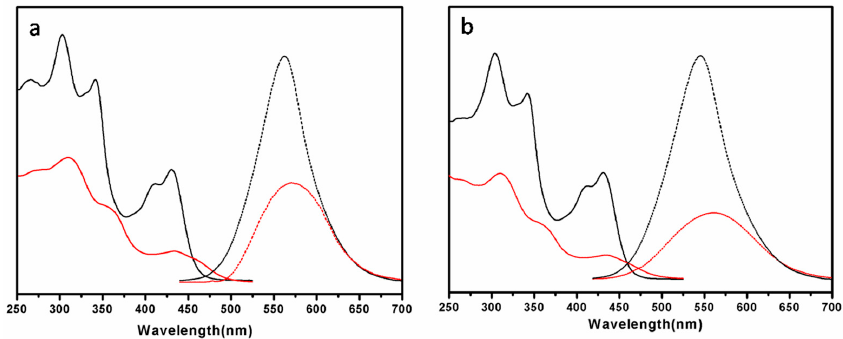
Figure 5. Absorption spectra (dash) and emission spectra (solid) of ( a ) 1 , and ( b ) 2 in CH 2 Cl 2 (black) and in aqueous solution (red), with 0.01 wt %. and in aqueous solution (red), with 0.01 wt